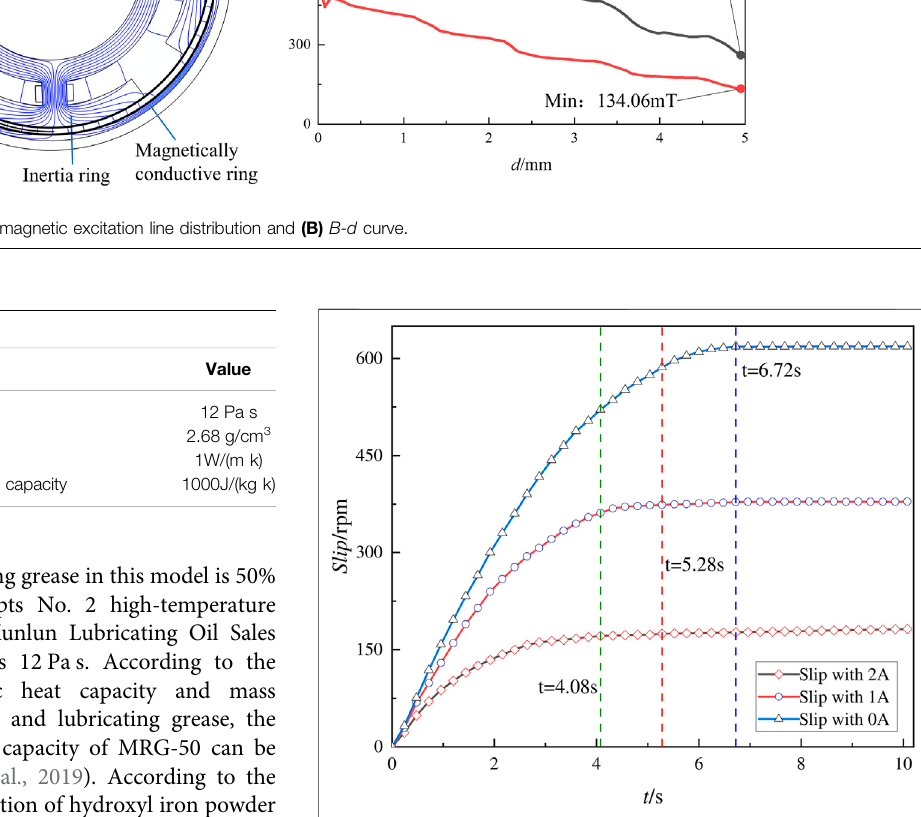
FIGURE 7 | Slip of shell and inertia ring for each working